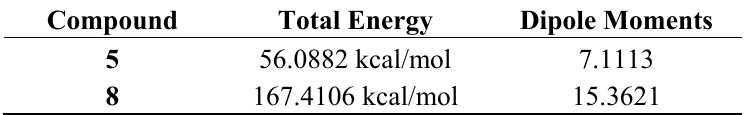
Table 1. Total energy and dipole moments (Debye) for compounds 5 and 8 .